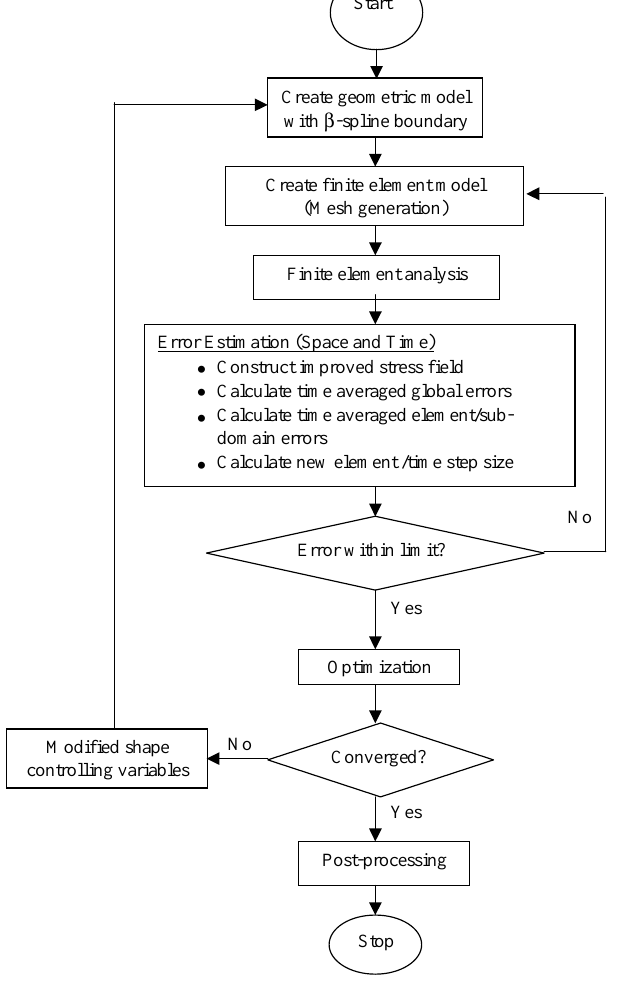
Fig. 1. Flow chart for the simulation